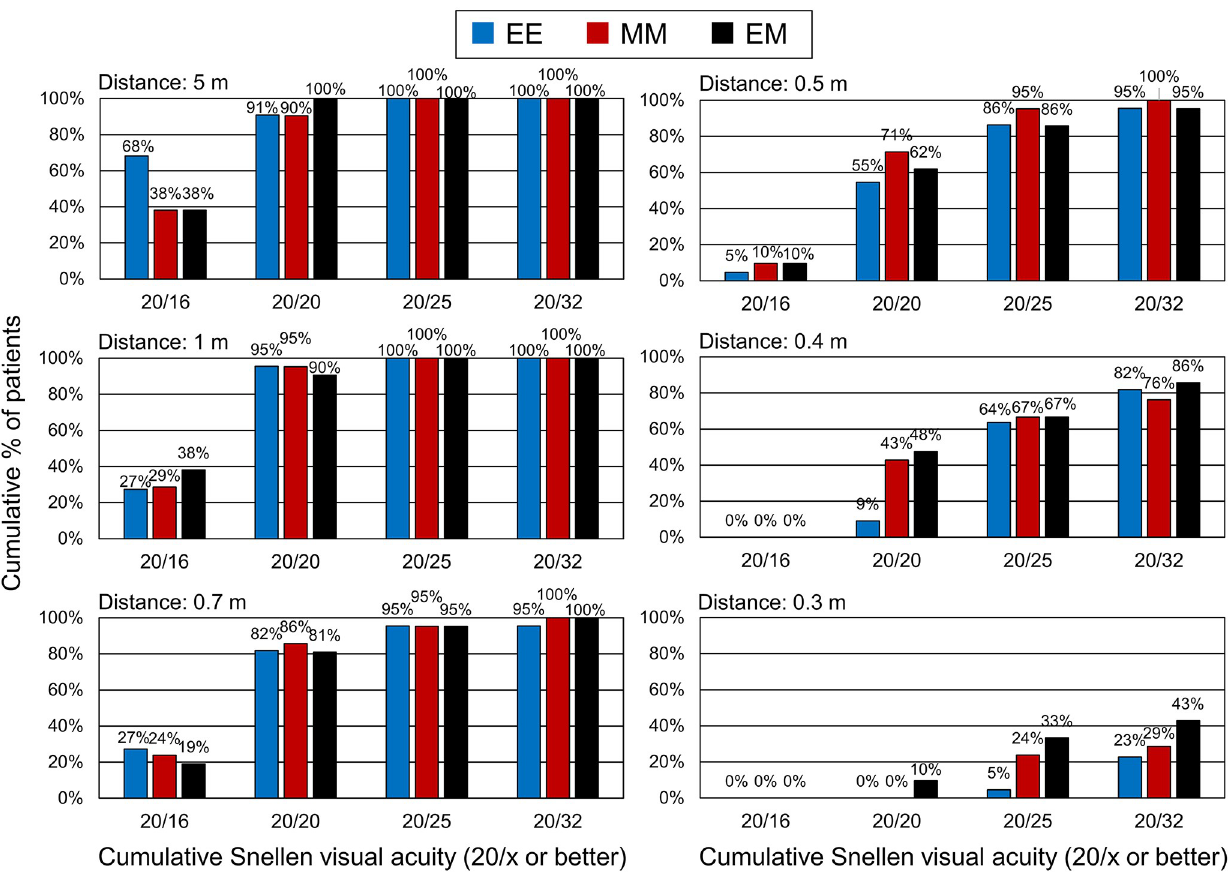
Fig 4. Histograms of binocular uncorrected visual acuities at distances of 5, 1, 0.7, 0.5, 0.4, and 0.3 meter in three groups. EE: bilateral emmetropia, group MM: bilateral -0.5 diopters, and Group EM: monovision of emmetropia and -0.5 D.